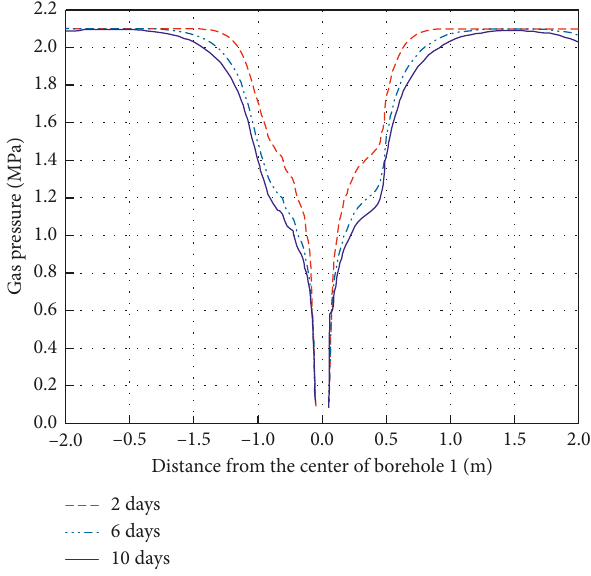
Figure 15: Curves for gas pressure distribution on the vertical fracture